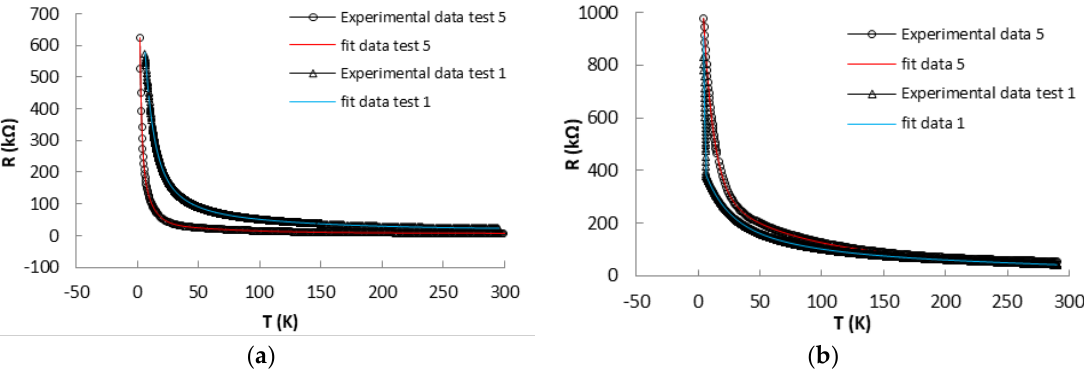
Figure 4. Resistance vs. Temperature (R-T) curves for: Sensor 1 ( a ); and Sensor 2 ( b ).